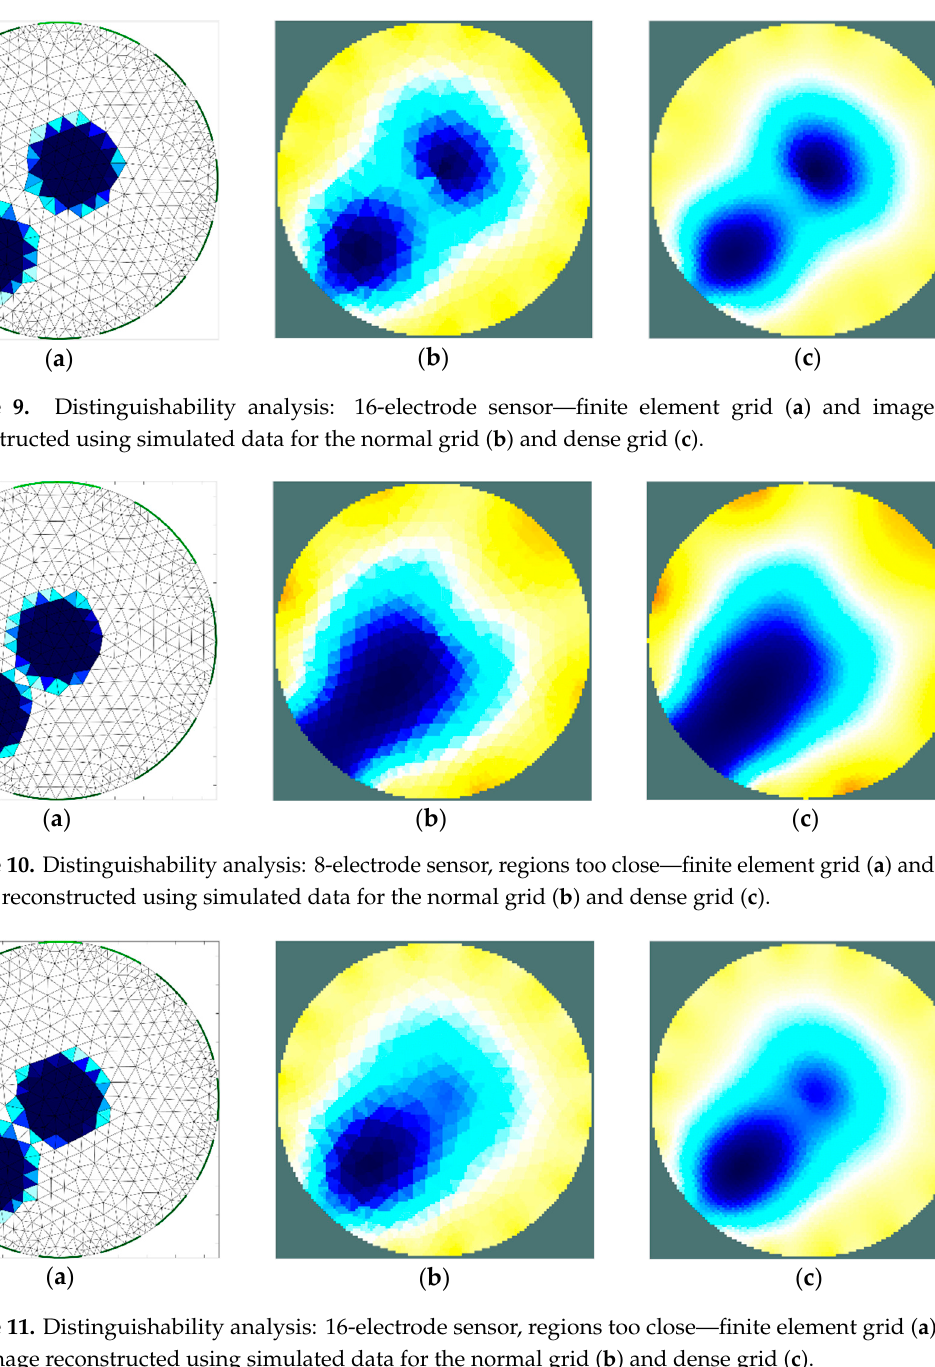
( c ) Figure 12. Case 1: Chokeberry with water content of 69.0%/35.2%. Reconstructed images for voltage stimulation of 100 Hz ( a ), 1 kHz ( b ), 10 kHz ( c ).